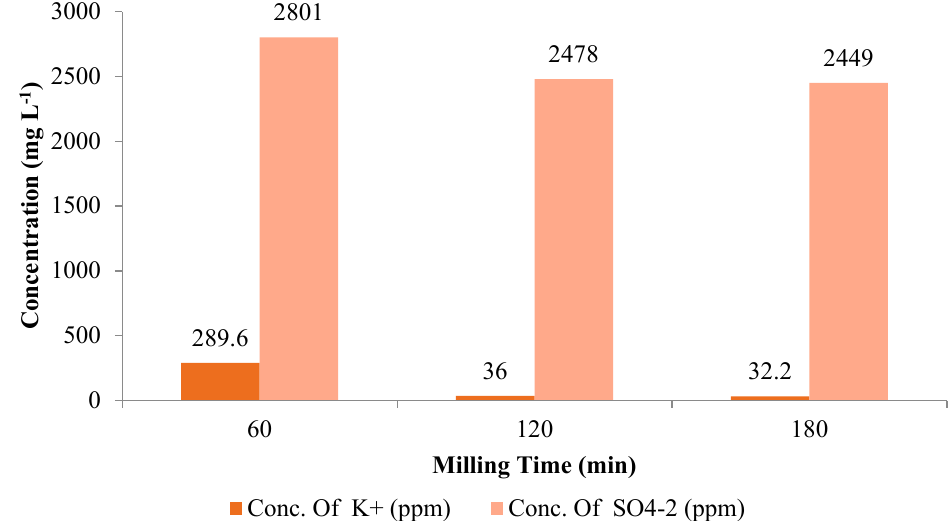
Figure 4. Profile of produced nutrient mixtures dispersed in distilled water at different milling times with constant milling speed 700 rpm.